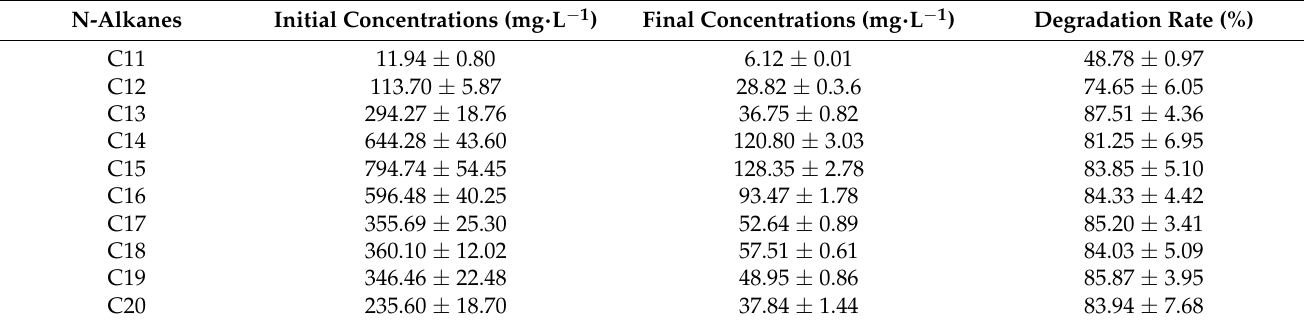
Table 2. Residual n-alkanes concentrations of 1% diesel oil in MSM medium for 7 days.